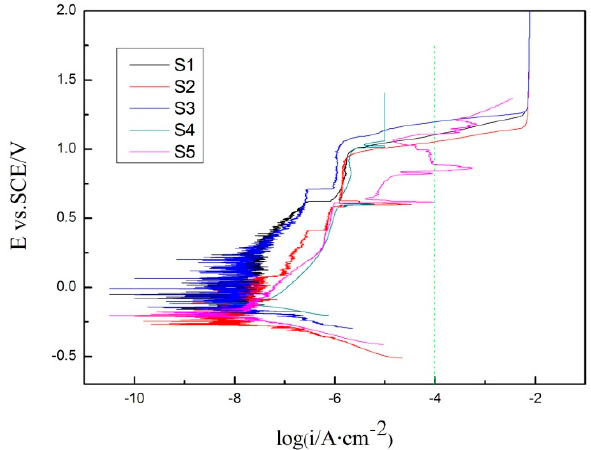
Figure 6. The potentiodynamic polarization curve of samples processed with different conditions. Table 5. The results of electrochemical experiments.